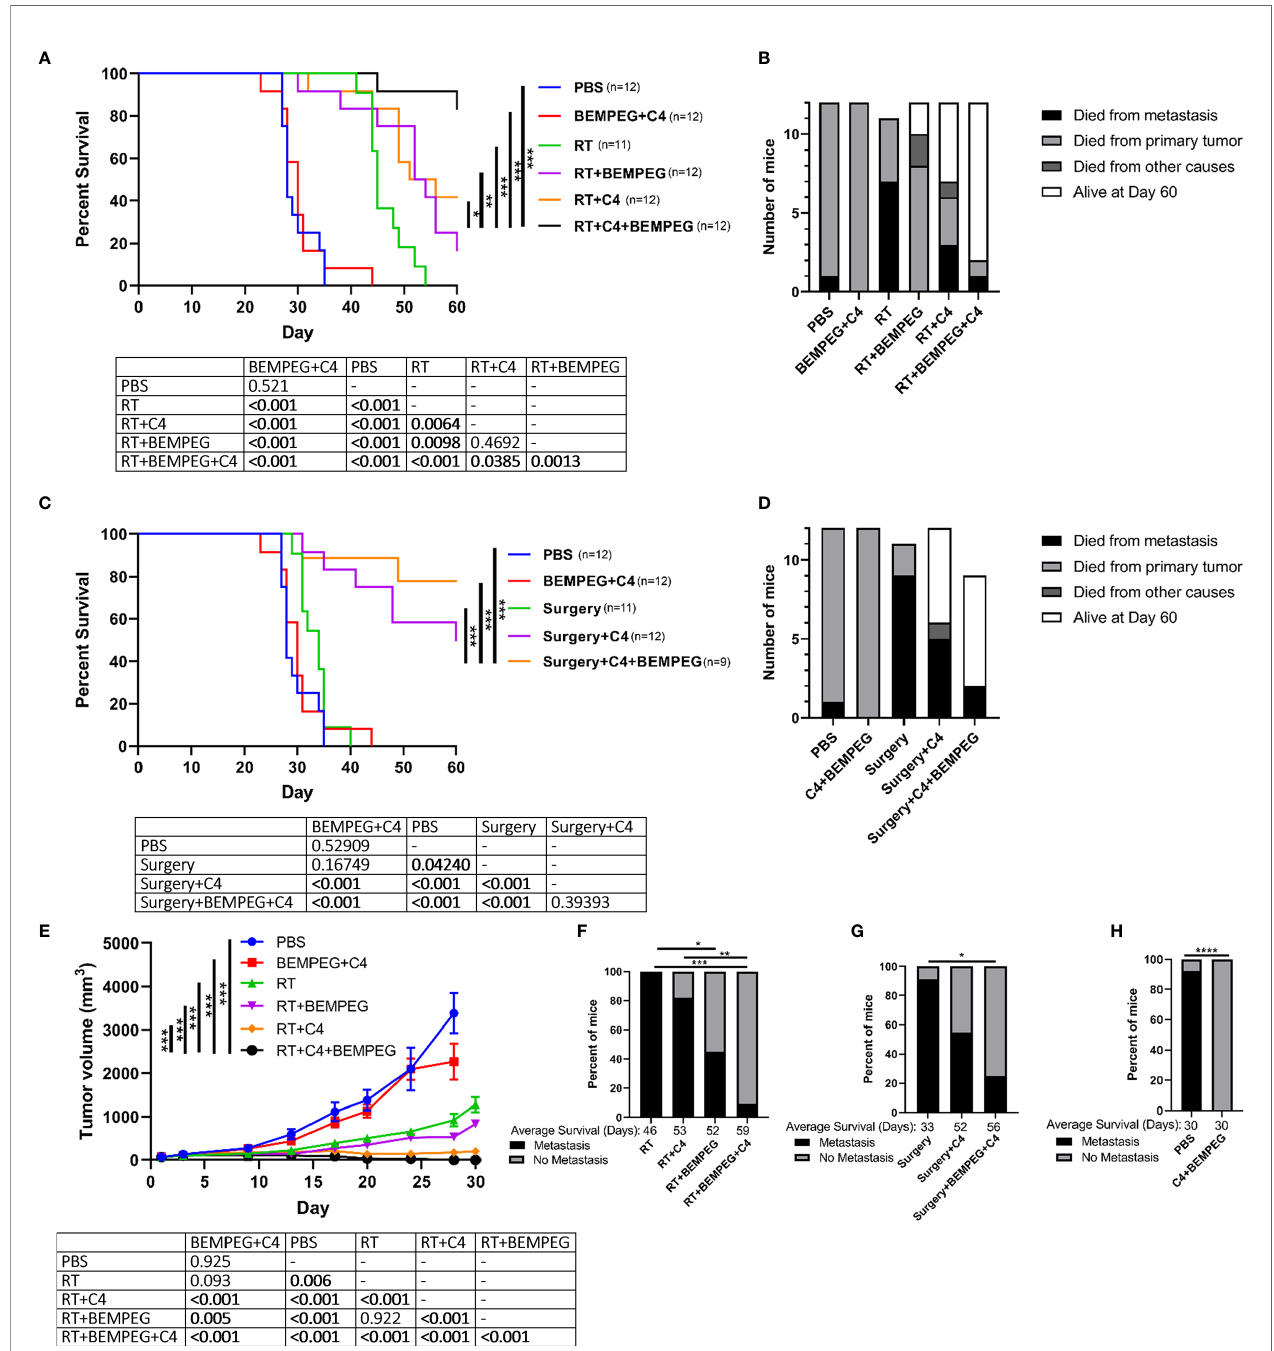
FIGURE 1 | BEMPEG and anti-CTLA-4 with local tumor treatment leads to tumor regression and increased survival in a single fl ank tumor model. In mice bearing a fl ank LLC tumor (~80mm 3 on day 1), tumors were treated with 8 Gy x 3 daily fractions (days 1, 2, 3) or were surgically resected (day 16). Local treatment was combined with BEMPEG, anti-CTLA-4 (C4), or PBS control treatments. (A, C) Survival curves (Kaplan – Meier and Log-rank pairwise comparison with Benjamini- Hochberg adjustment for p-values, n ≥ 10, 2 independent animal experiments) are shown comparing RT+C4+BEMPEG or surgery+BEMPEG+C4 to controls. (B, D) Cause of death is graphed for mice receiving the indicated treatments. (E) Tumor volume growth curves are shown comparing RT+C4+BEMPEG to controls (linear mixed effects model, mean ± SEM, n ≥ 5, replicate experiment and individual mouse growth curves are shown in Supplemental Figure 6 ). (F – H) At the time of death, metastatic disease was determined via India ink staining of the lungs. Fisher ’ s exact test and a post-hoc pairwise comparison with Benjamini-Hochberg adjustment for p-values were used for statistical analyses. ****= P <0.0001; ***= P <0.001; **= P <0.01; *= P